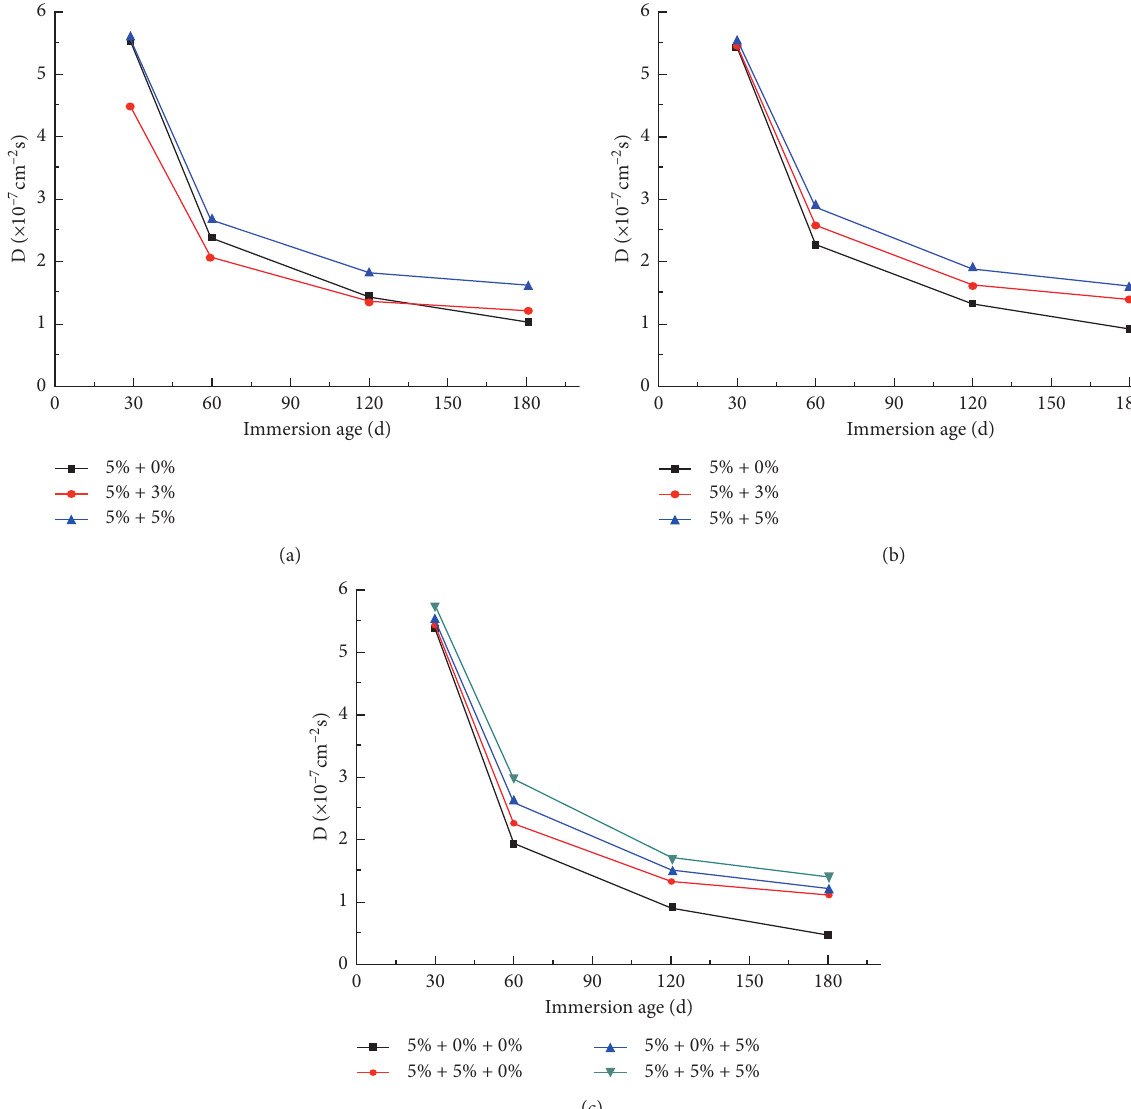
2 SO 4 +MgSO 4 , (b) Na 2 SO 4 +NaHCO 3 , and (c) Na 2 SO 4 +5%